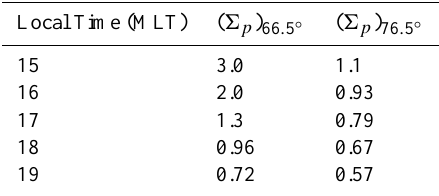
Table 1. The ionospheric Pedersen conductances estimated from the IRI-90 model (Bilitza, 1990) for the four hours of local time that the field line resonance